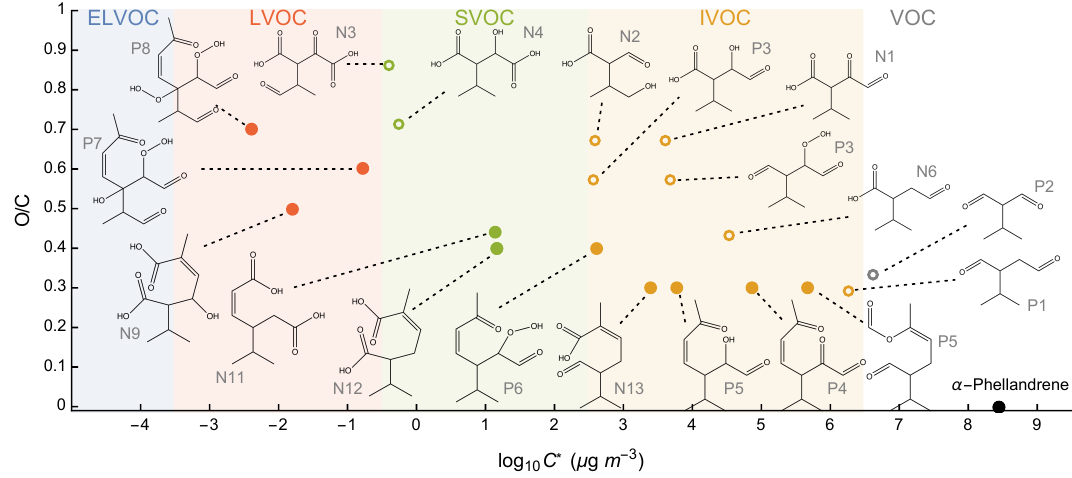
Figure 6. α -Phellandrene and detected particle-phase ozonolysis products from both positive and negative ESI modes plotted in two dimen- sional volatility–oxidation space, constrained by saturation concentration on the x axis and O / C elemental ratios on the y axis. Molecular structures of products are shown. Filled and open circles denote first- and second-generation products, respectively, with coloured regions indicating broad volatility classes. The volatility distribution can be compared with gas-phase species through Fig. 9 in Mackenzie-Rae et al.